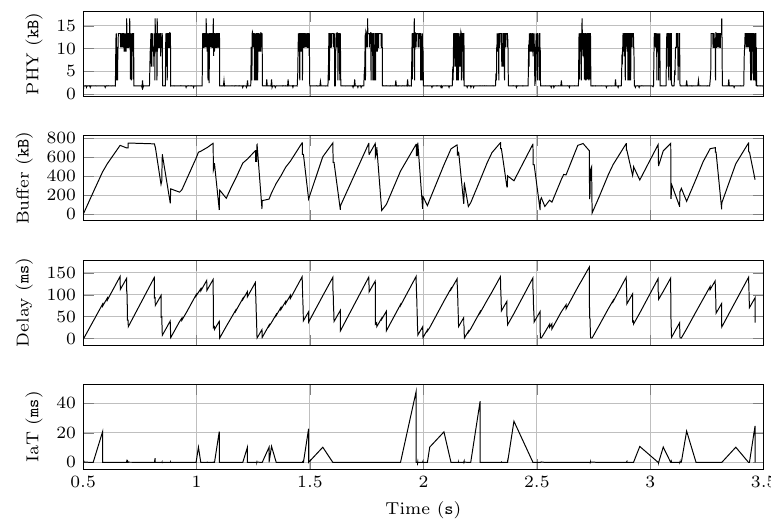
Figure 3. System parameters with distance and traffic rate of 30 m and 50 Mbps, respectively, using max weight